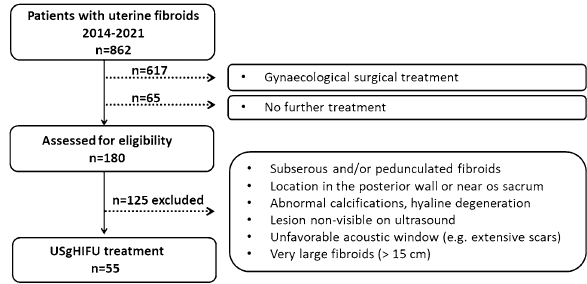
Figure 2. Study consort diagram: assessment for